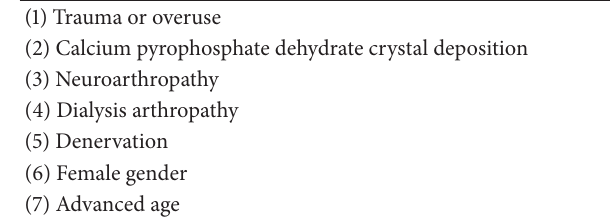
Table 1: Associated risk factors for Milwaukee shoulder syndrome.